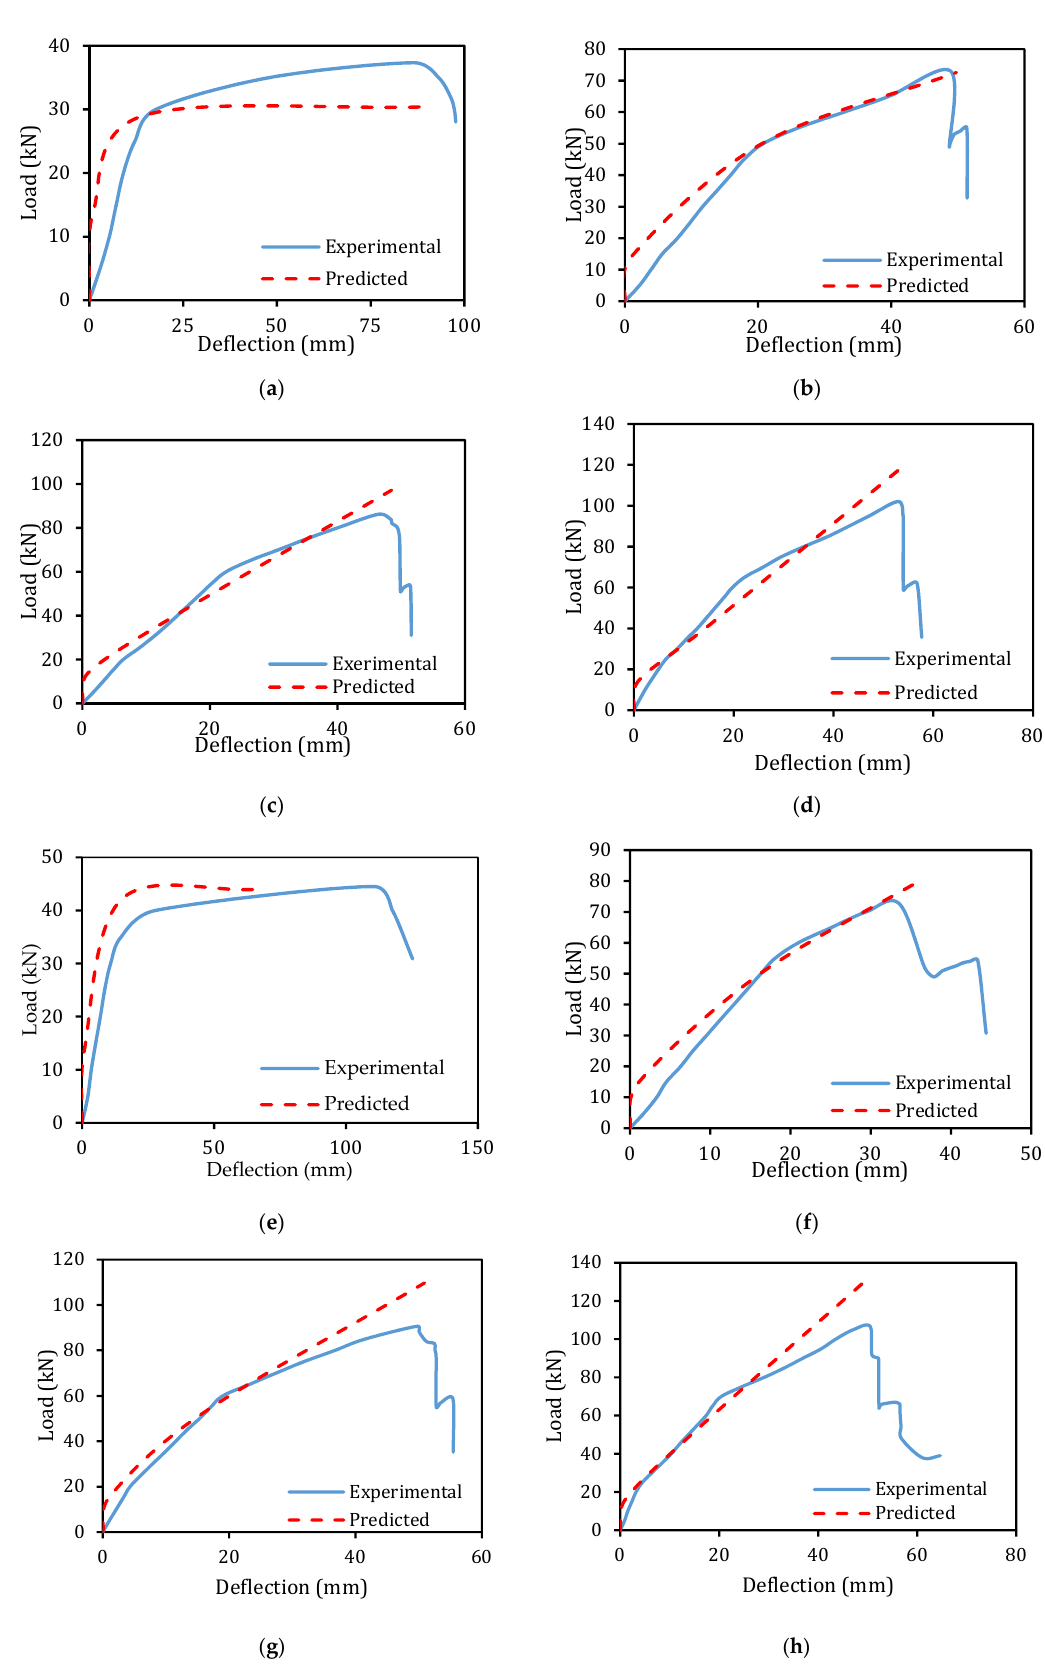
Figure 17. Predicted load-deflection graph comparison. ( a ) CB-A; ( b ) SE-A; ( c ) SE-2A; ( d ) SE-3A; ( e ) CB-B; ( f ) SE-B; ( g ) SE-2B; ( h ) SE-3B.